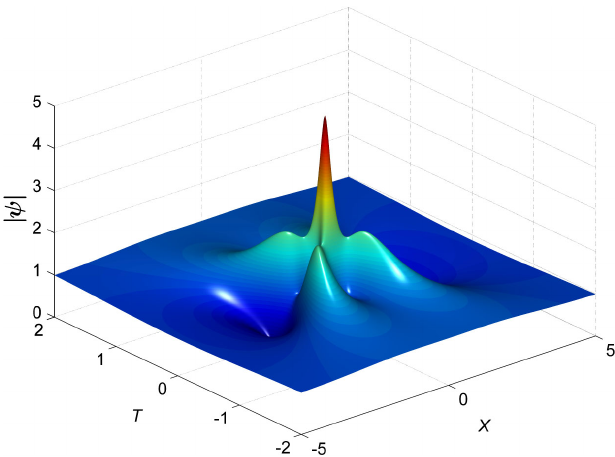
FIG. 2. (a) Photo of the water-wave tank with the surface- elevation gauge. Waves are generated with the paddle located at the far end of the tank. (b) Schematic illustration of the facility including the paddle, the gauge, and the